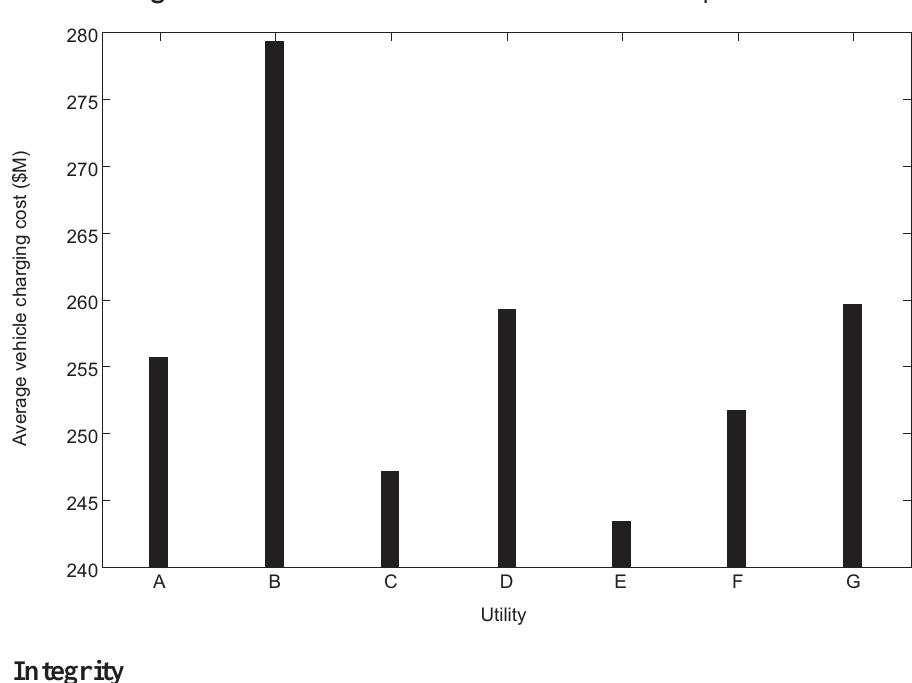
Figure 16. Customer costs associated with load